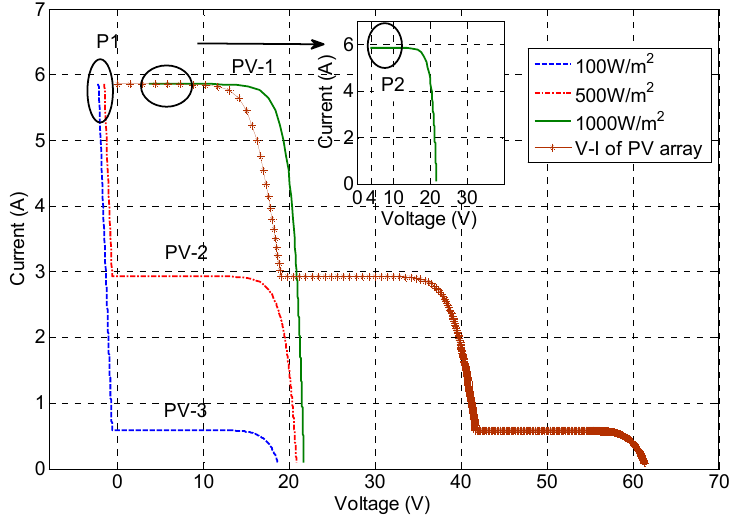
Figure 2. Each I-V curves of cell groups in a module.